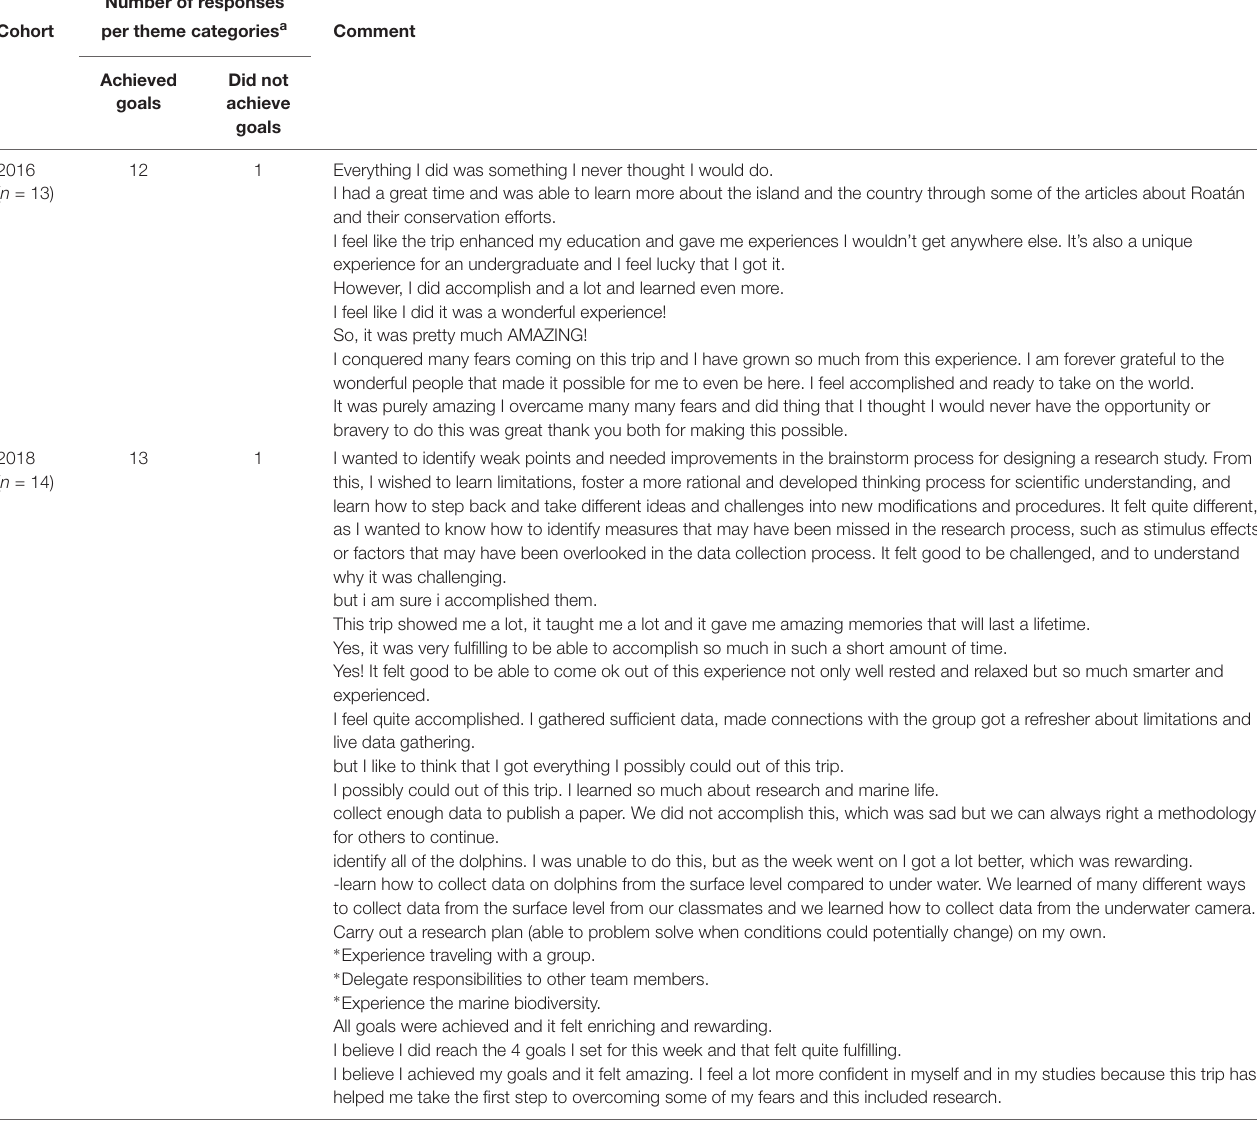
TABLE 1 | Summary of themes and comments produced by field study students regarding goal